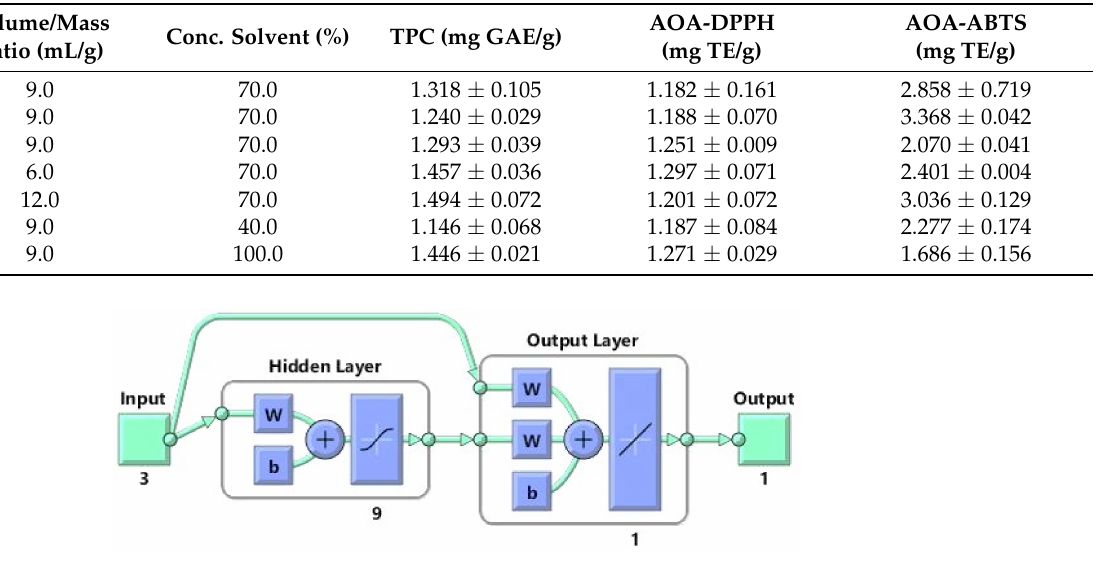
Figure 2. Best network topologies with the Levenberg-Marquardt training algorithm for prediction of total phenolic compounds (TPC). Table 4. Best topologies included in training algorithms, various layers and neurons for estimation of total phenolic compounds